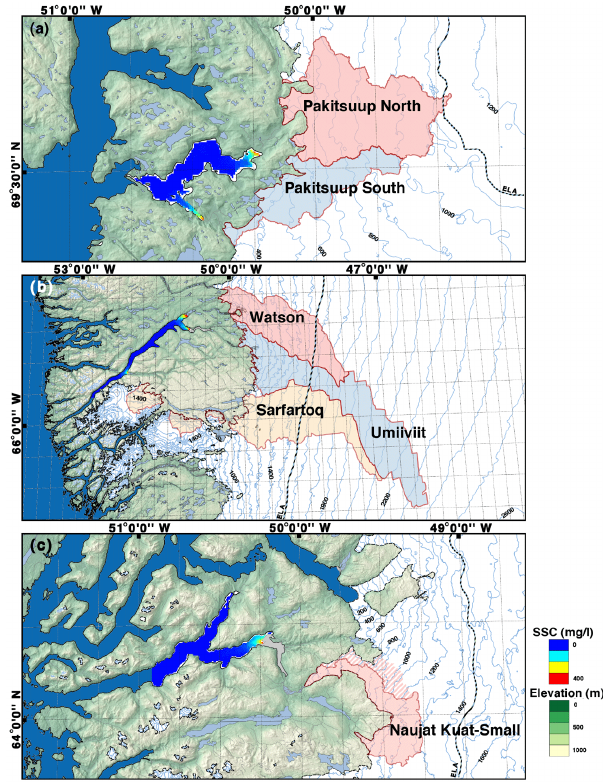
Figure 3. Land surface digital elevation model (DEM), ice sheet to- pographic contours, and glacier catchment area for rivers and fjords discussed in paper. Land DEM and ice sheet contours were derived from the GIMP DEM. Equilibrium line altitudes (ELA) discussed in Sect. 2 also plotted on ice sheet for reference, as are 13 year mean SSC concentration. For (c) , Naujat Kuat-Small is delineated with sold pink color. The entire Naujat Kuat catchment combines both solid and diagonal striped pink regions. Latitude and longitude grid is in 0.25 decimal degree